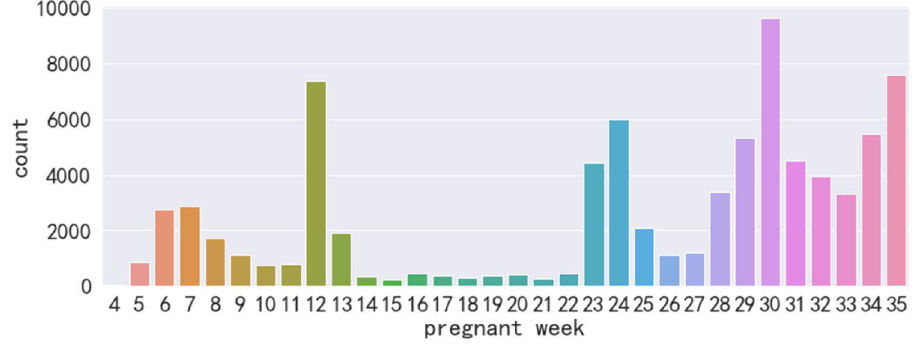
Figure 2. Count of the pregnant women in different pregnant